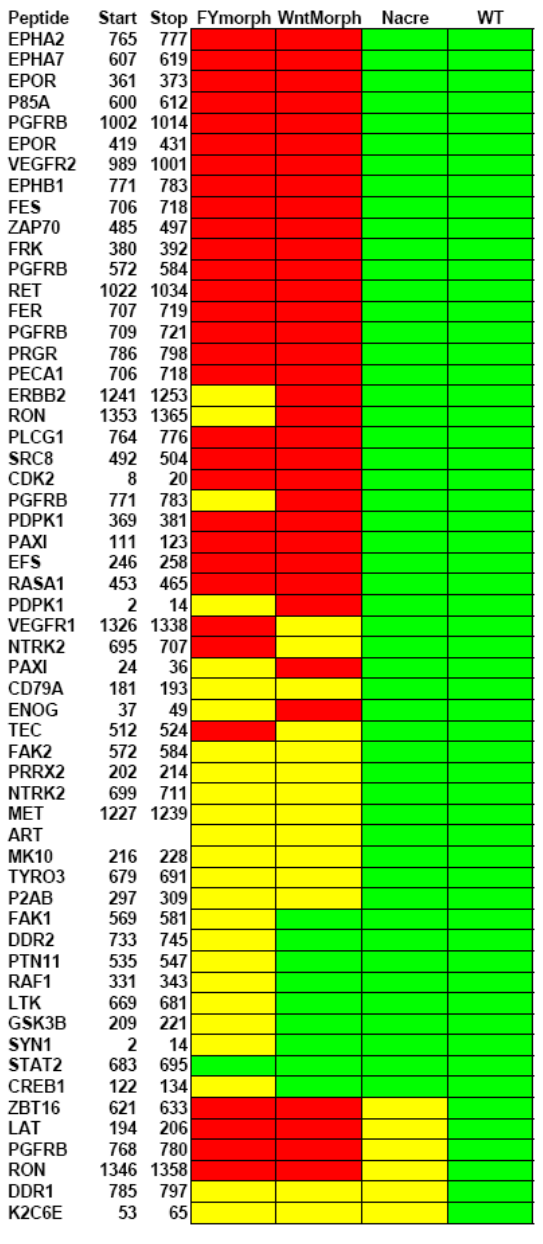
tyrosine (Exalpha, USA), and 400 m M ATP (Sigma) to the PamChip peptide array. Prior to application of the sample, the chips were blocked using a solution of 2% BSA (Bovine Serum Albumin, Fraction V, Calbiochem, Germany), and washed 2 times using